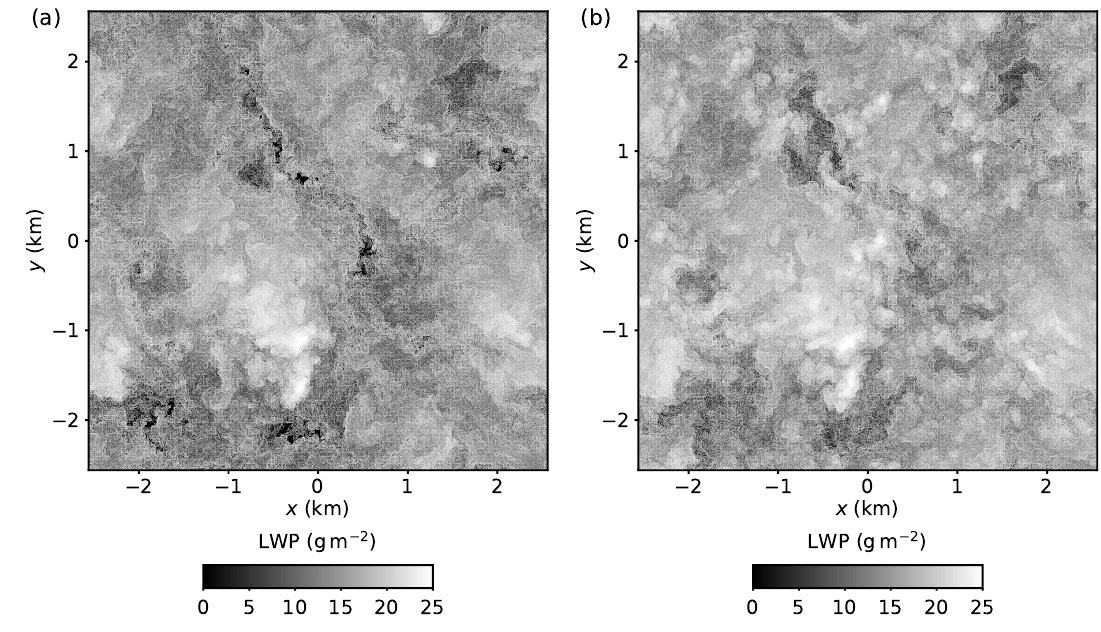
Figure 9. Liquid water path of the bottom-half of the cloud: ( a ) Case A1, and ( b ) Case